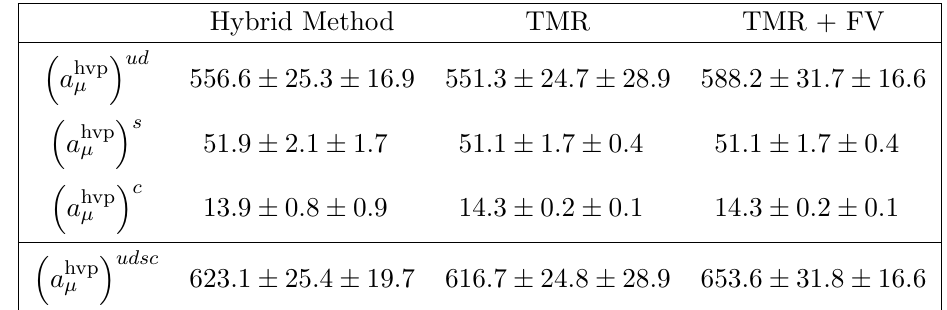
Table 7 . Summary of results for the hadronic vacuum polarization contribution (in units of 10 (cid:0) 10 ) at the physical point. The (cid:12)rst error is statistical while the second denotes the systematic uncer- tainty as estimated via the variations listed in table 6. The rightmost column contains the estimate for ( a hvp ) ud including corrections for (cid:12)nite-size e(cid:11)ects. (cid:22) lattice spacing a . Another important systematic e(cid:11)ect is associated with constraining the deep infrared regime of the vacuum polarization: in the case of the hybrid method we have used di(cid:11)erent values of the momentum scale Q 2 below which the vacuum polarization cut function is described by a low-order Pad(cid:19)e